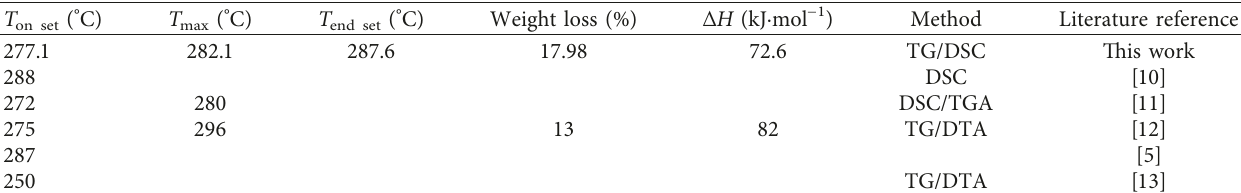
Table 5: Comparative values of melting-decomposition parameters of L-histidine reported by different researchers. T on set ( ° C)